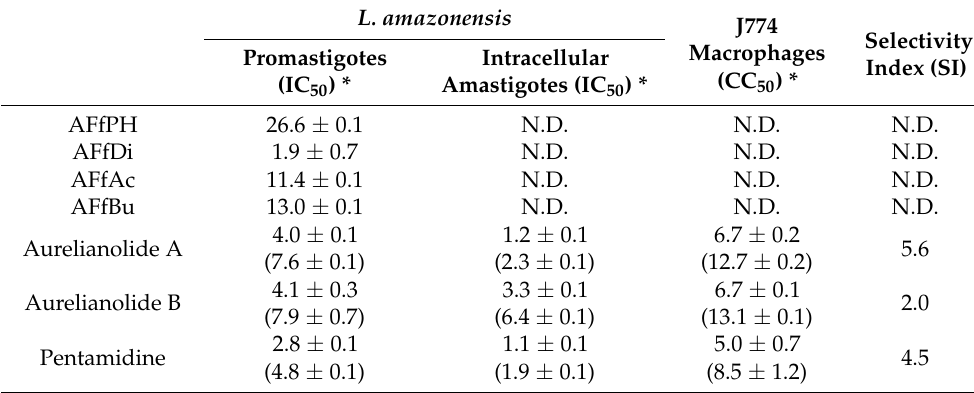
Table 1. Antileishmanial activity, cytotoxicity, and selectivity index for fractions and withanolides from Aureliana fasciculata .